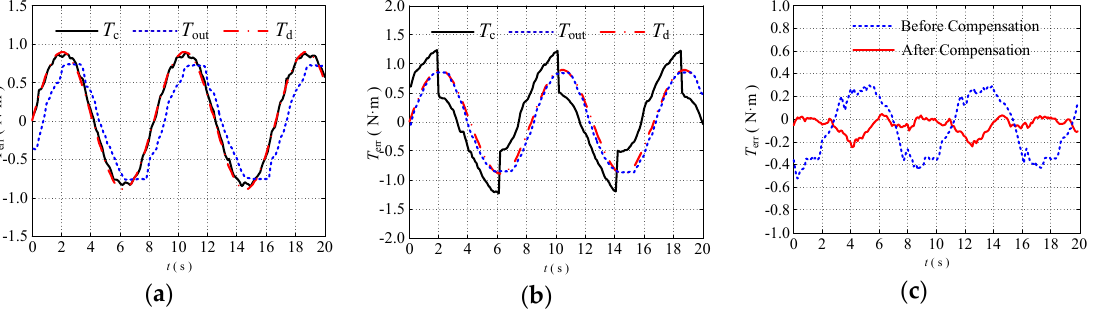
Figure 12. Torque tracking experiment with 2 kg end load under external disturbance; ( a ) before compensation; ( b ) after compensation; ( c ) torque tracking error.